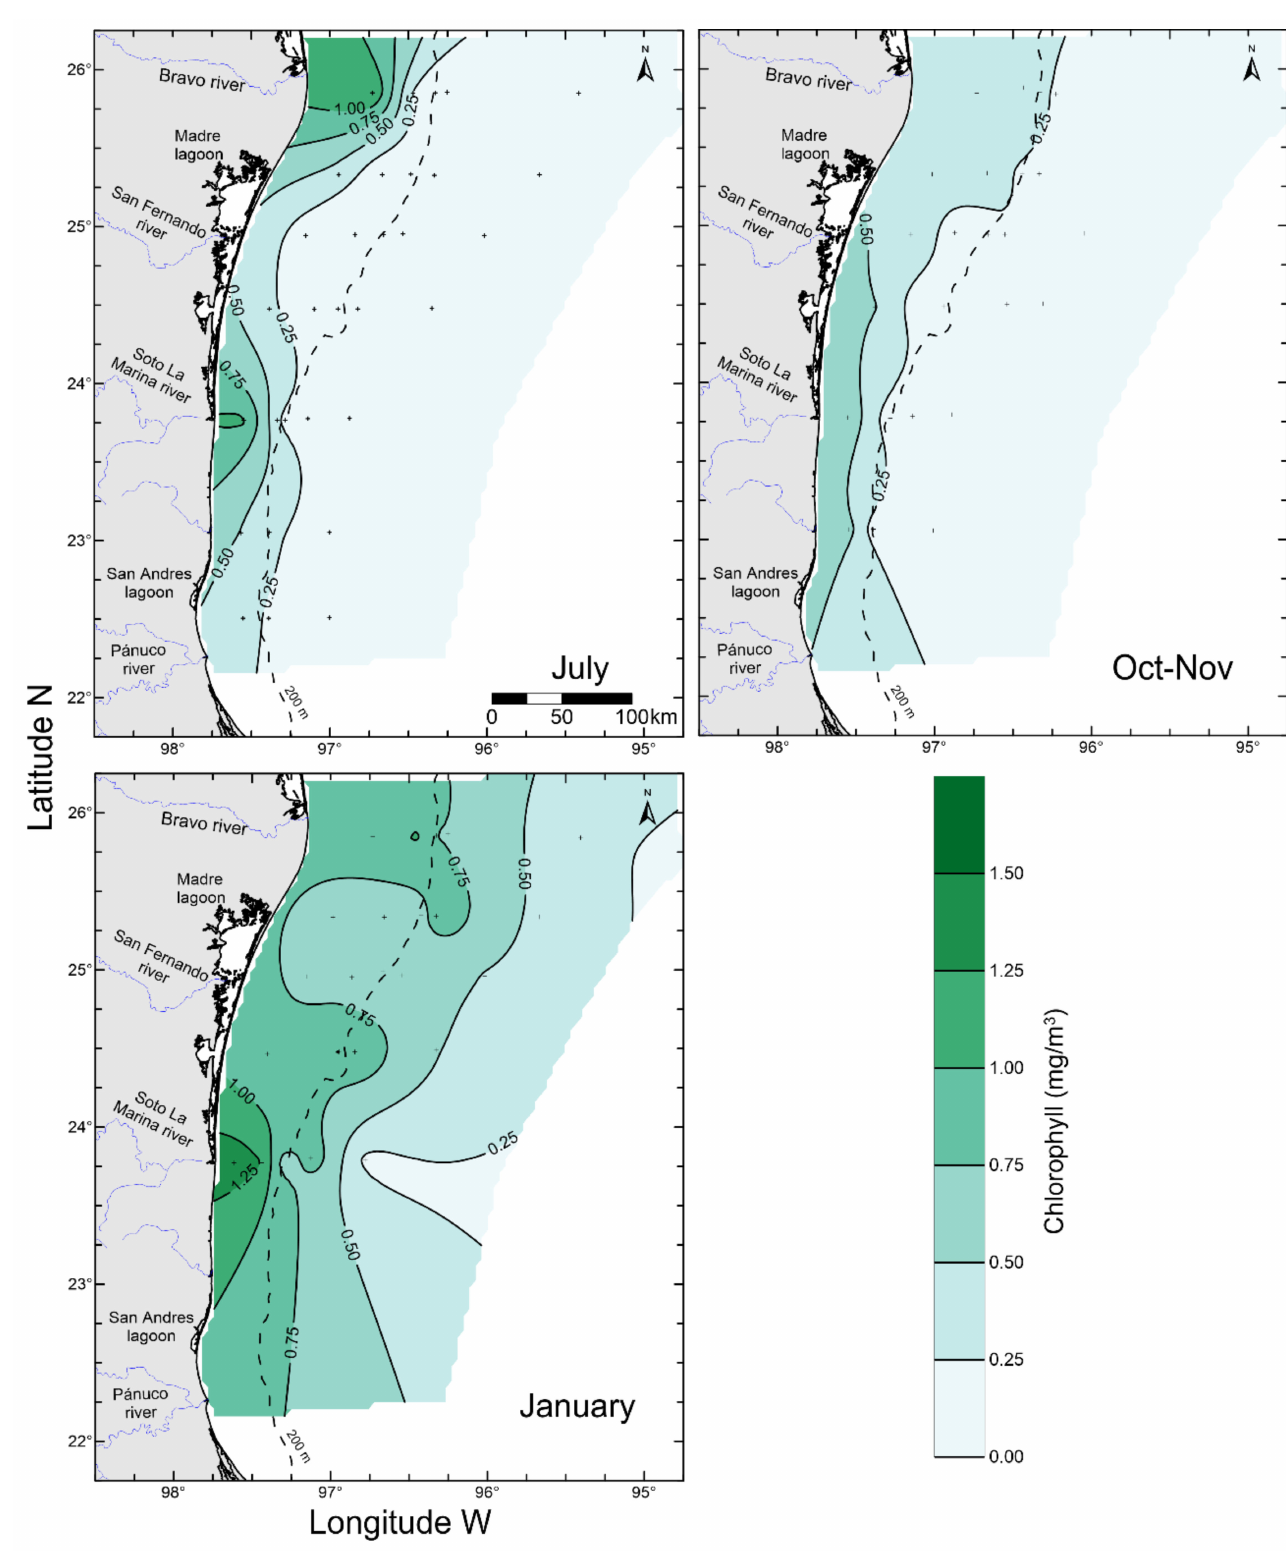
Figure 4. Mean integrated chlorophyll concentration (mg m − 3 ) in the upper 50 m layer in the western Gulf of